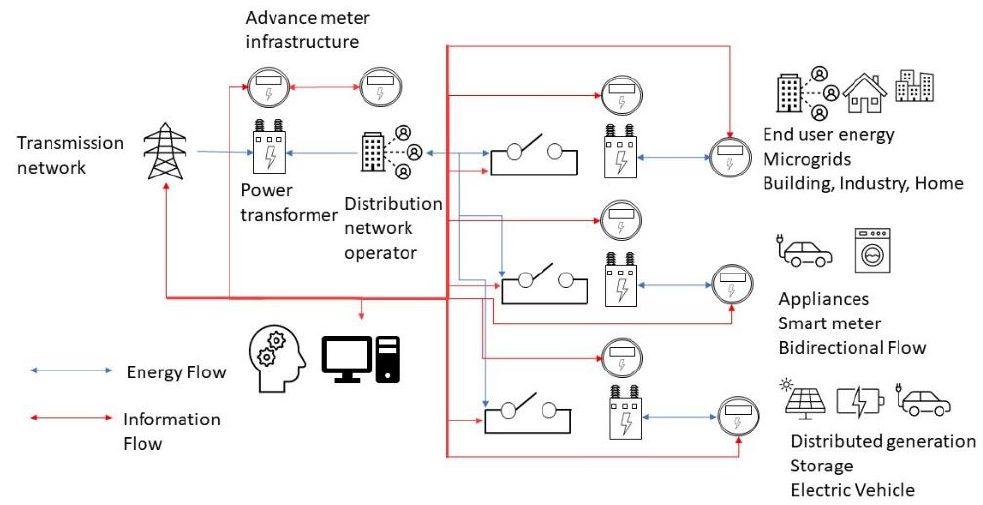
Figure 3. Flow of energy and information in the grid and microgrid.